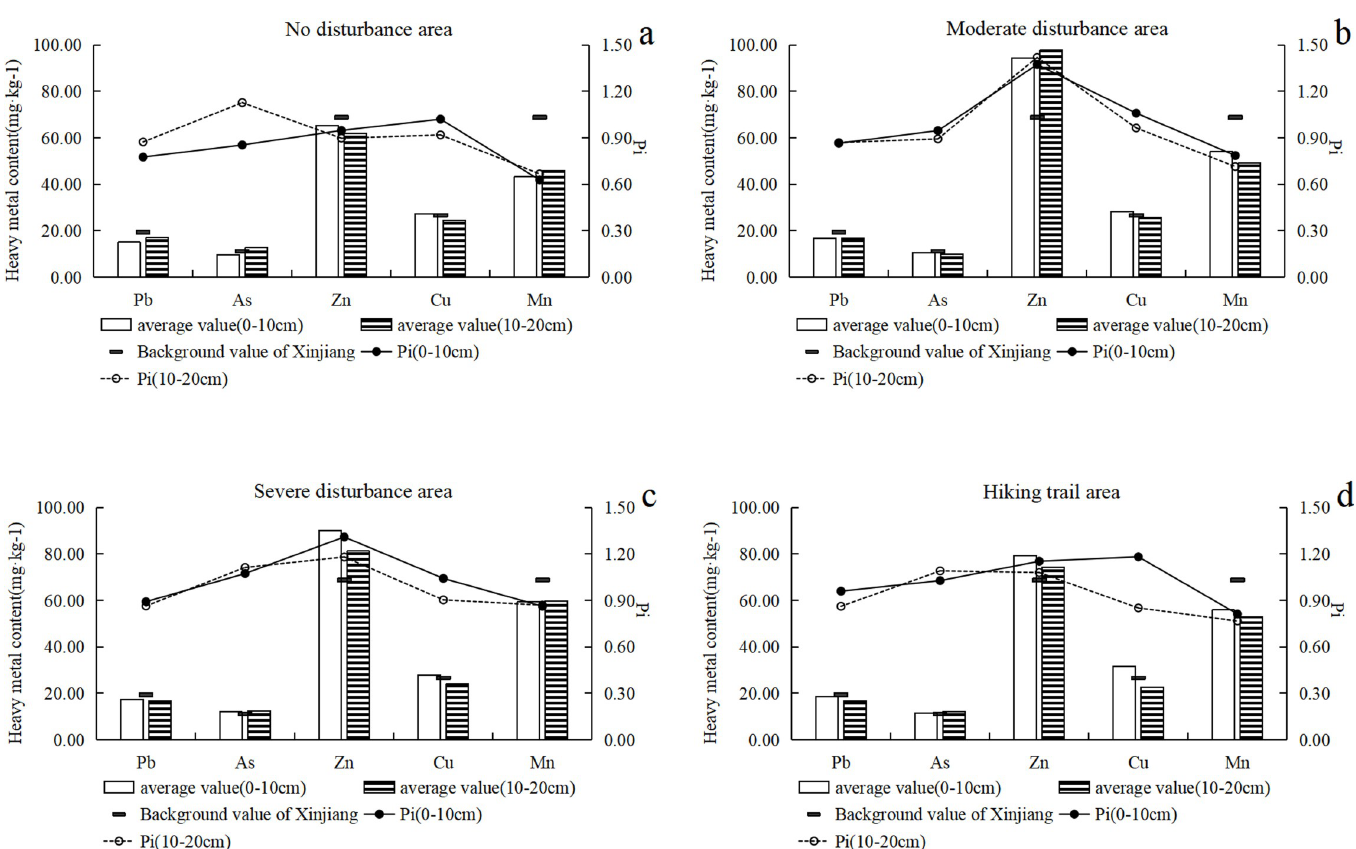
Fig 4. Heavy metal concentration in soil under different disturbance levels in Juhuatai Scenic Area.